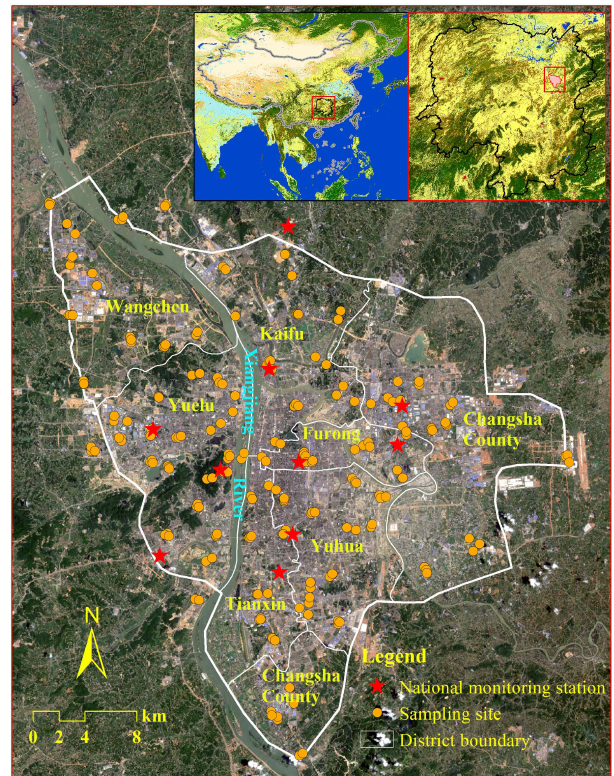
Figure 2. Sampling area and PM 2 . 5 sampling